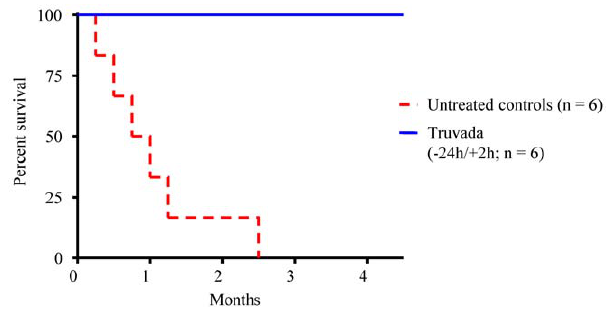
Figure 2. Complete protection against vaginal SHIV trans- mission by intermittent PrEP with Truvada. Survival curves represent the cumulative percentage of uninfected macaques as a function of the number of months in the study period (4 challenges per month). Control macaques become infected after a median of 3.5 exposures or about 1 menstrual cycle. Virus challenges in the macaques receiving Truvada were stopped after 18 SHIV SF162P3 exposures or about 4.5 menstrual cycles. Protected animals remained seronegative and